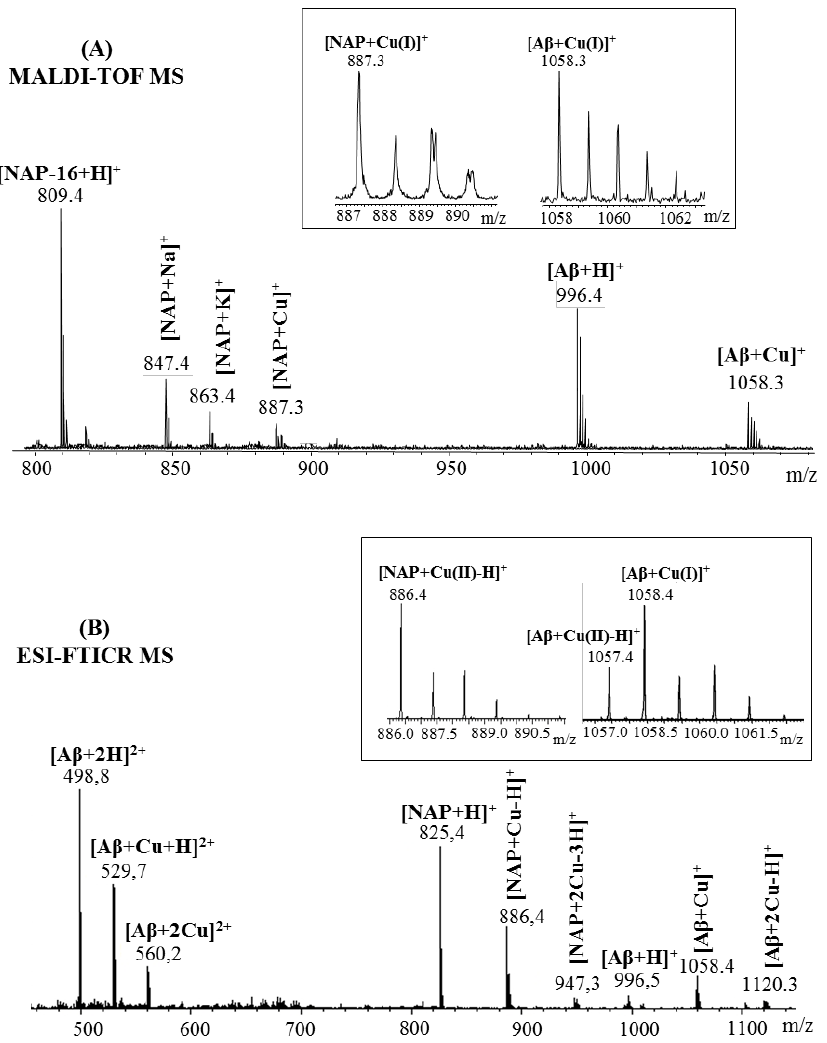
Figure 6. Enlarged region of mass spectra of both NAP and A β (9–16) peptide incubated with Cu 2+ ions acquired by ( A ) MALDI ToF (reflectron mode) with CHCA matrix and ( B ) ESI-FTICR, both in positive mode. Inserts: ( A ) details of theoretical and experimental isotopic patterns of [M + Cu-H] + ion; ( B ) details of the double-positive-charged peptide